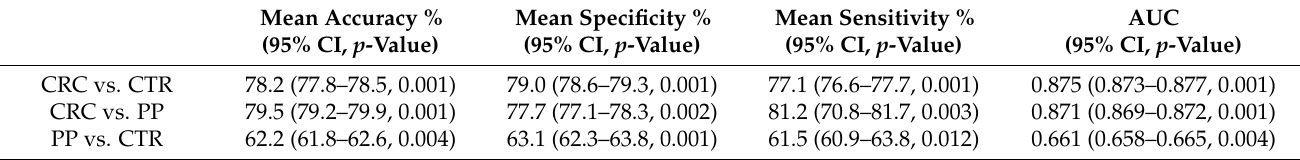
Table 1. Mean values of accuracy, specificity, sensitivity and area under the curve (AUC) of RF models built comparing CRC vs. CTR patients, CRC vs. PP patients, and PP vs. CTR